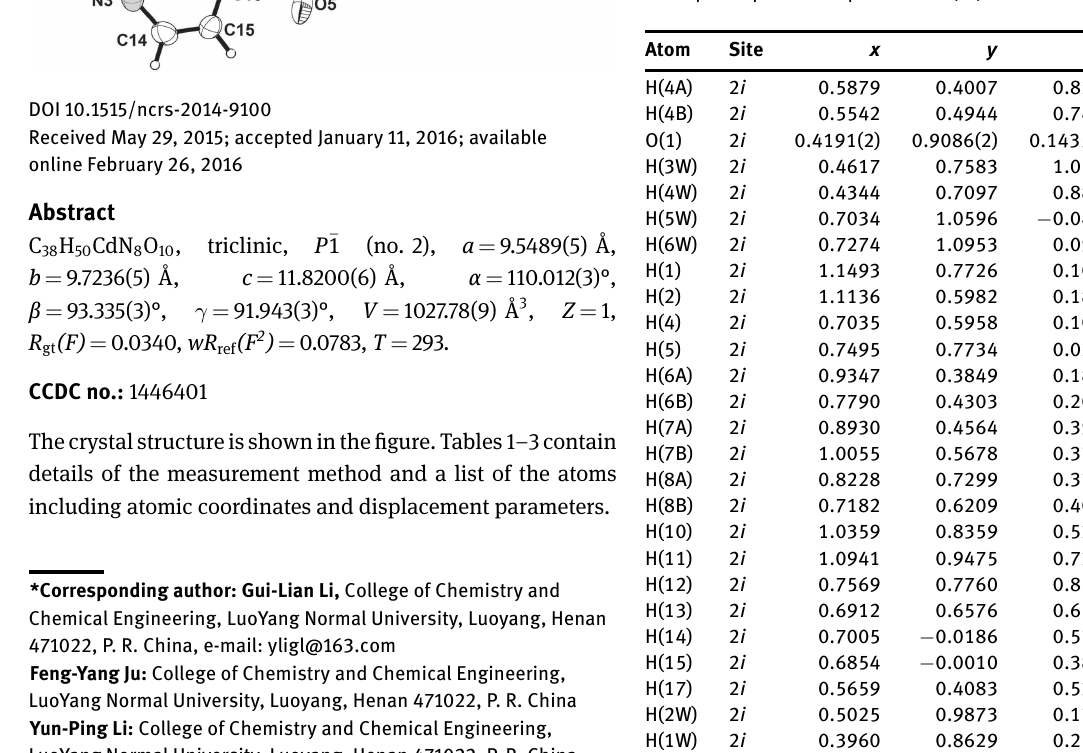
Table 2: Fractional atomic coordinates and isotropic or